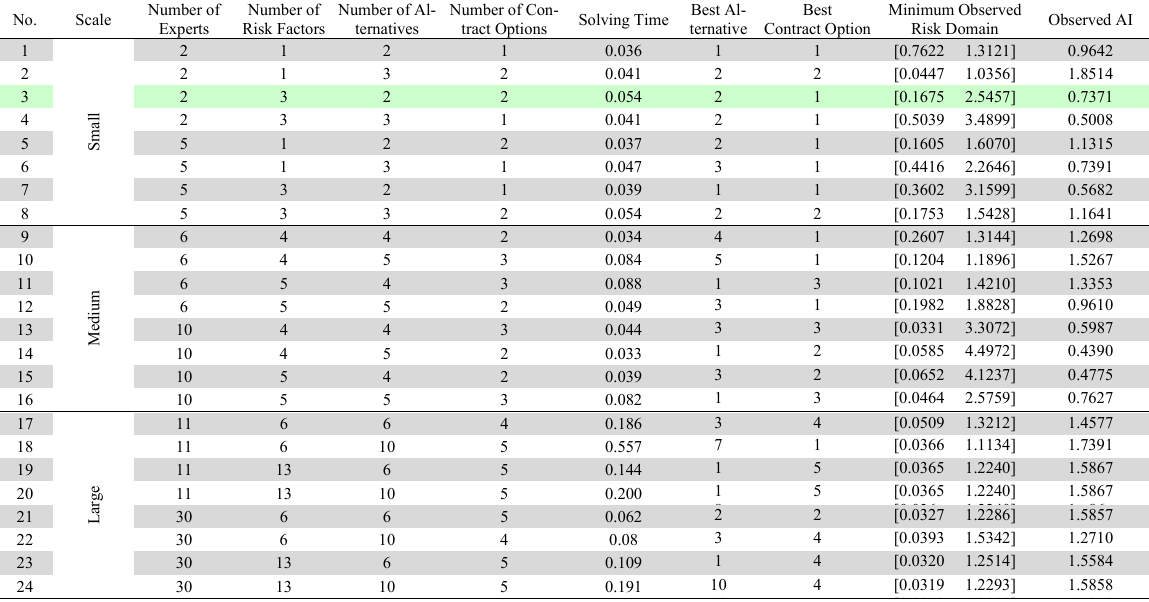
Results of Solving Numerical Experiments Using the Proposed Hybrid AHP and Theory of Evidence Algorithm No. Scale Number of Experts Number of Risk Factors Number of Al- ternatives Best Contract Option Minimum Observed Risk Domain Observed